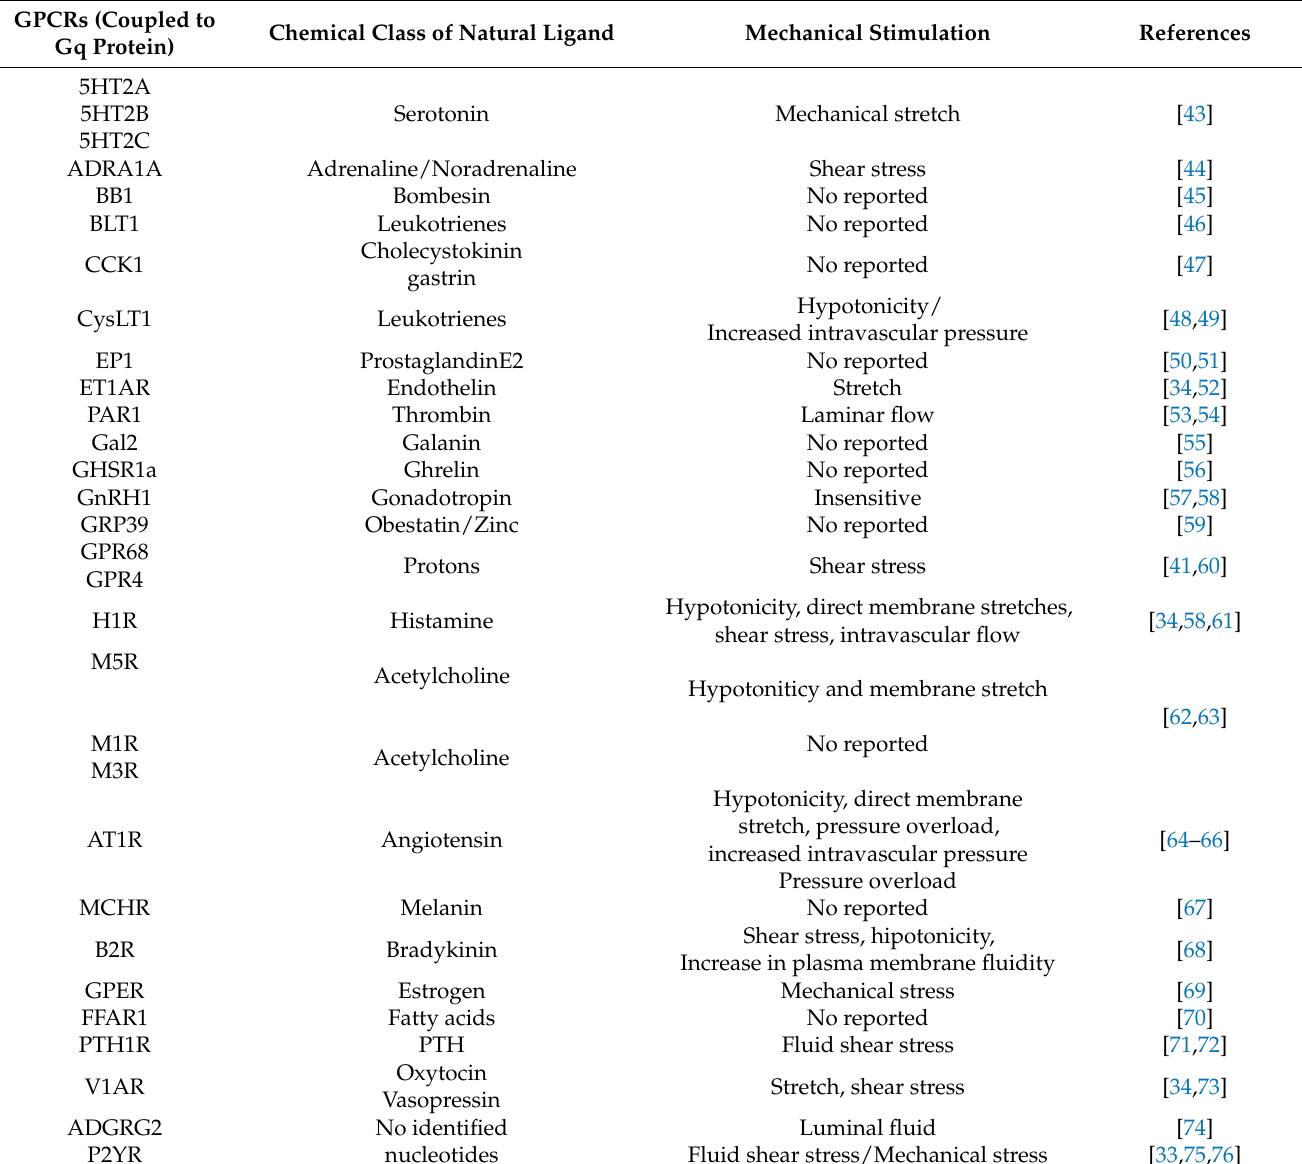
Table 1. Gq-coupled GPCRs and their